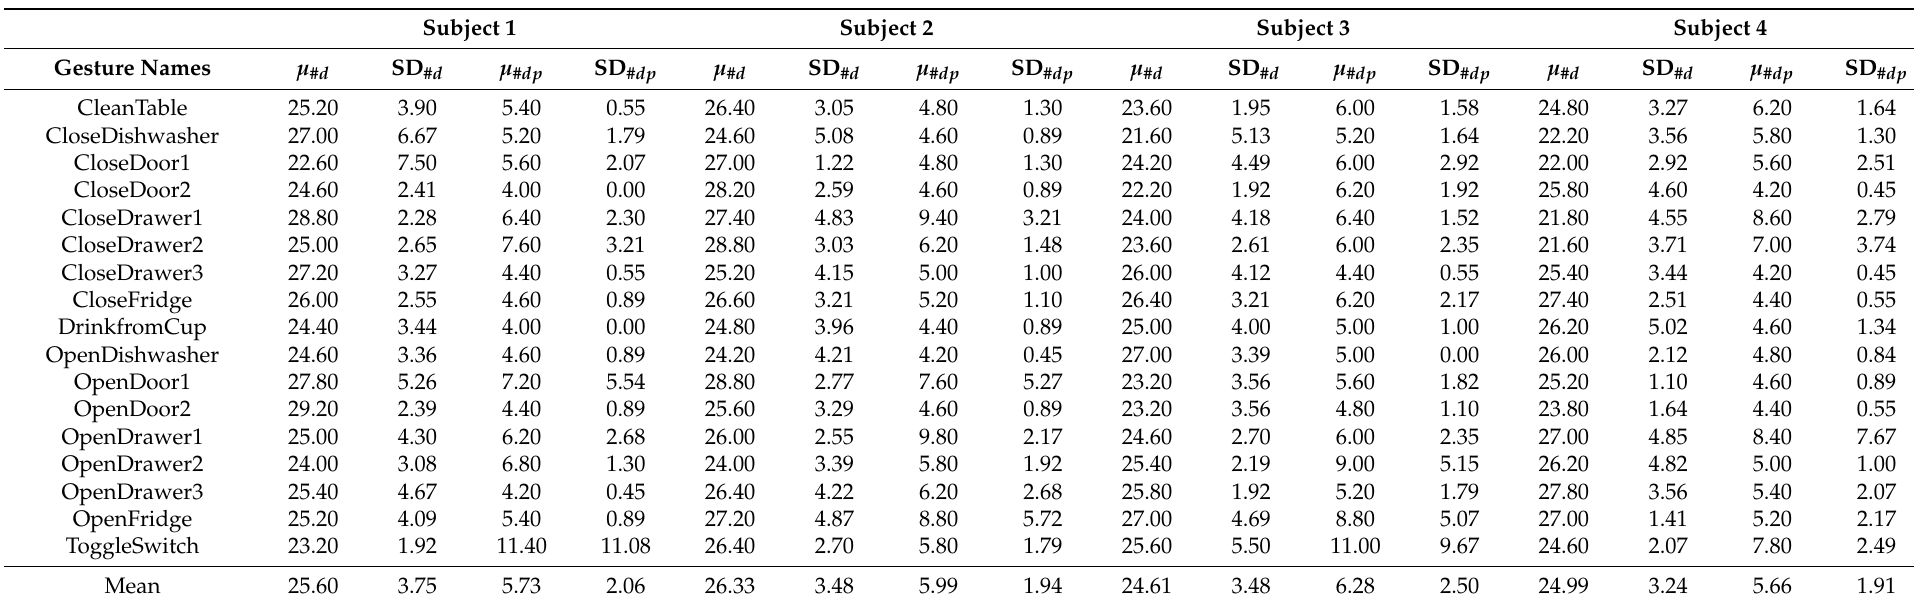
Table 3. Average cut points and selected features obtained by MOFSD-GR Ameva